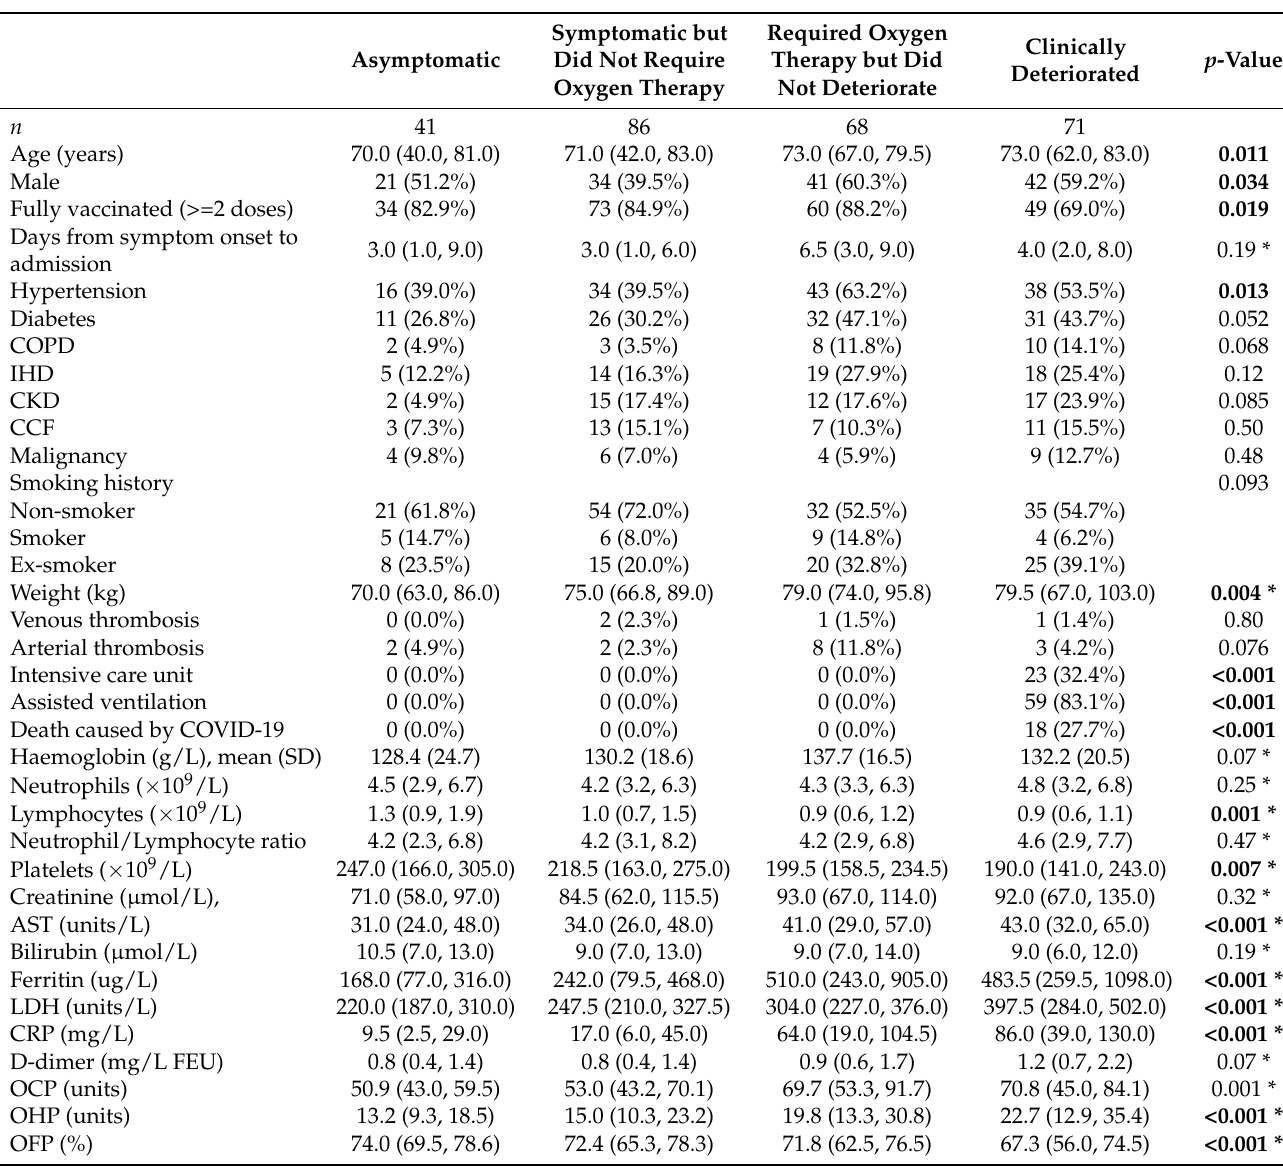
Table 2. Baseline characteristics, laboratory results and clinical outcomes of COVID-19 patients from 2022 categorized by disease severity. Data are n (%), and median (interquartile range, IQR), unless specified